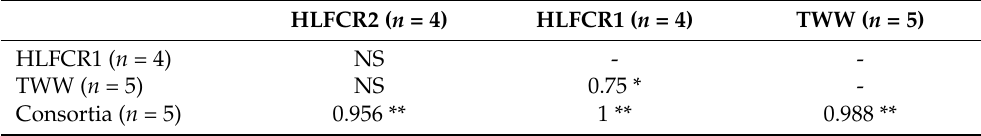
Table 2. ANOSIM significant R values ( dsrB amplicon Global R = 0.435 ***). HLFCR2 ( n = 4) HLFCR1 ( n = 4) TWW ( n = 5) HLFCR1 ( n = 4) NS